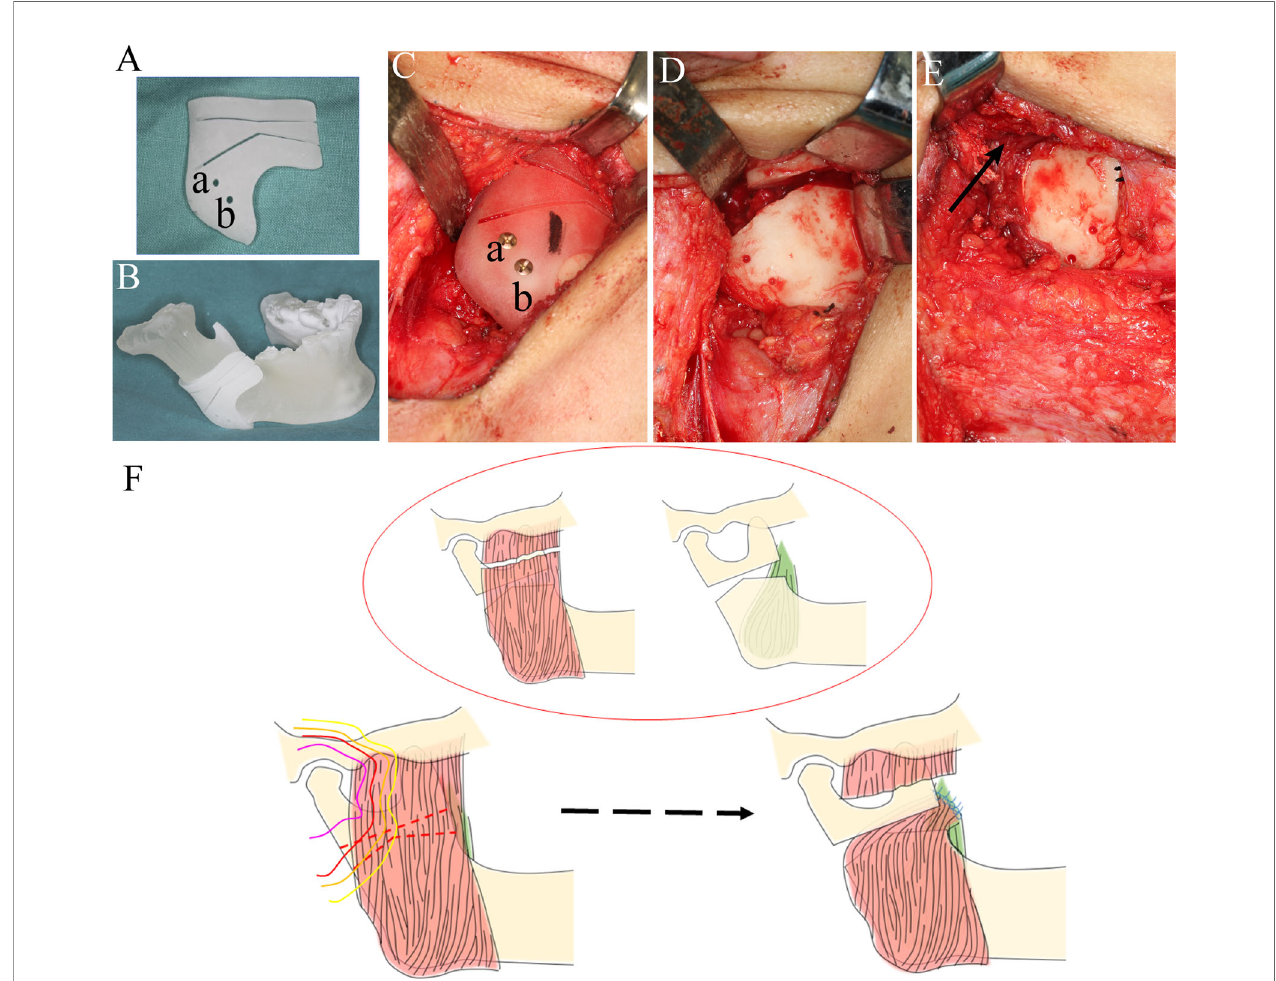
FIGURE 3 | Surgical procedure and graphic presentation. (A) A 3D-printed custom guide was fabricated to con fi rm the osteotomy plane. (B) A 3D-printed custom mandible was fabricated. Two drills were designed (a, b) to fi x the guide (B, C) . (C) The guide was fi xed on the right mandibular angle. (D) Osteotomy was performed according to the design, and a 0.5 cm gap was made. (E) A pterygo-masseteric muscle fl ap was used as an inter-positional material (black arrow). (F) Sketh of the procedures of modi fi ed arthroplasty, and the colors of the lines were consistent with radiation doses in Figure 1